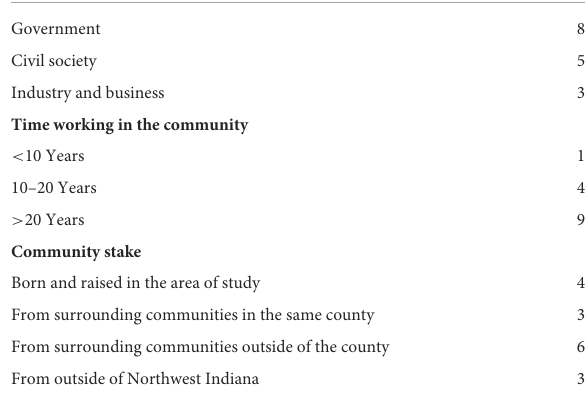
TABLE 3 Respondent